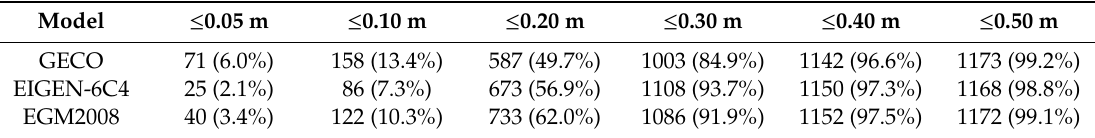
Figure 5. Histograms of the differences between the geoid heights (𝑁 𝐺𝑁𝑆𝑆/𝑙𝑒𝑣𝑒𝑙𝑖𝑛𝑔 ) derived from GNSS/leveling on the 1182 UCPs and the geoid heights (𝑁 𝐺𝐺𝑀 ) derived from the three KNGeoid models. ( a ) GECO; ( b ) EIGEN-6C4; and ( c ) EGM2008. Table 4. Percentage of the 1182 UCPs whose absolute values of differences between the geoid heights derived from the GNSS/leveling and those derived from the three GGMs.